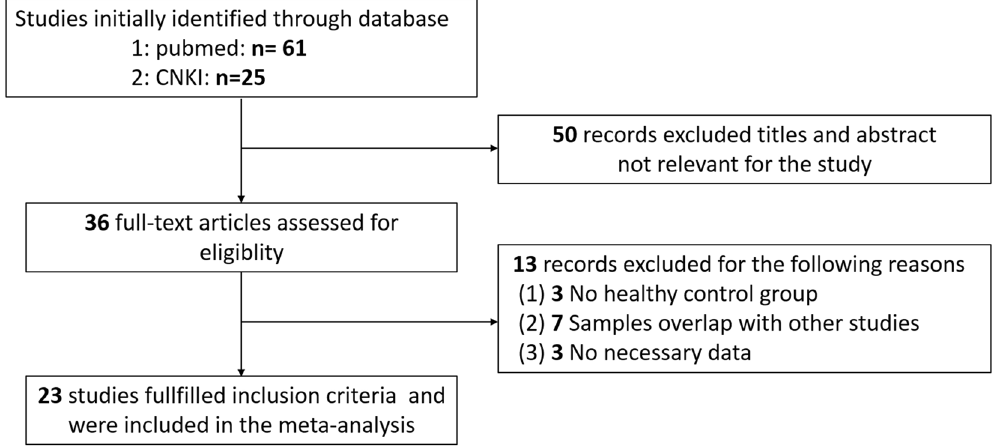
Figure 1. Meta-Analysis flowchart of the literature